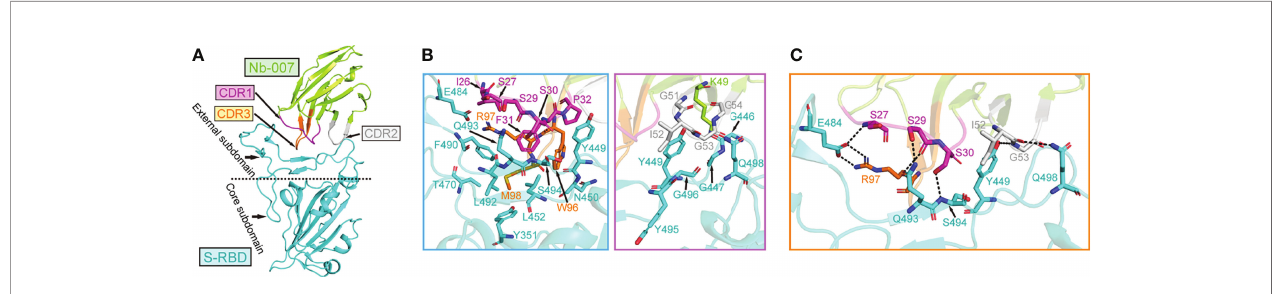
FIGURE 3 | The complex structure of Nb-007 bound to SARS-CoV-2 S-RBD. (A) A cartoon representation of the complex structure. Nb-007 is colored in lemon and S-RBD in cyan. The CDR1, CDR2 and CDR3 of Nb-007 are indicated with arrows and highlighted in magenta, gray and orange, respectively. The external subdomain and core subdomain of S-RBD, are roughly divided by a dashed line. (B) The multiple van der Waals (vdw) and hydrophobic interactions between Nb- 007 and S-RBD. The left panel, amino acid interactions between CDR1 and CDR3 of Nb-007 and S-RBD. The right panel, amino acid interactions between framework region and CDR2 of Nb-007 and S-RBD. Those residues providing ≥ 2 contacts are shown (the distance cutoff is 4.5 Å). (C) Hydrophilic interactions (hydrogen bonds and salt bridges) between Nb-007 and S-RBD (the distance cutoff is 3.1 Å).